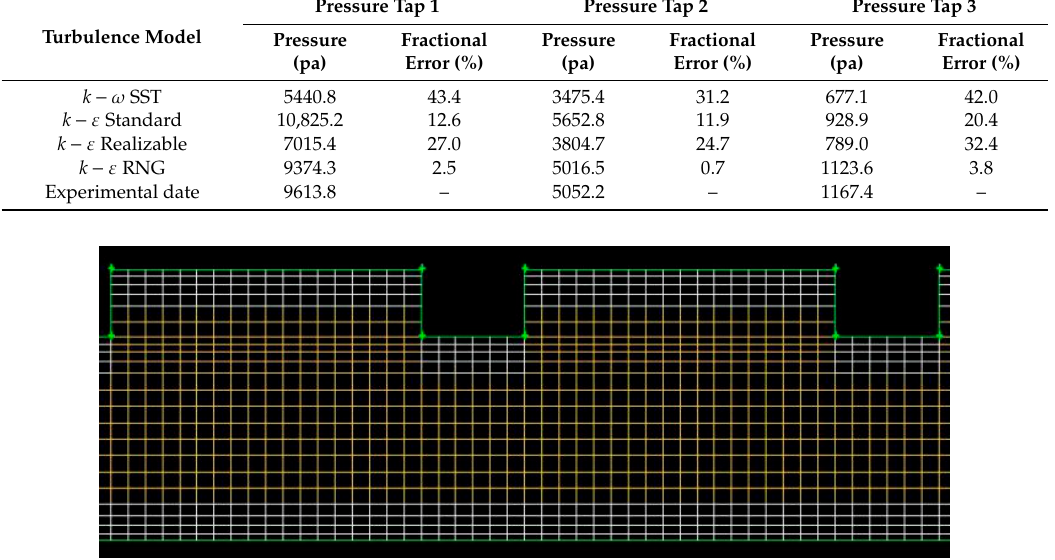
Figure 5. The mesh of a computational domain. Energies 2020 , 13 , x FOR PEER REVIEW